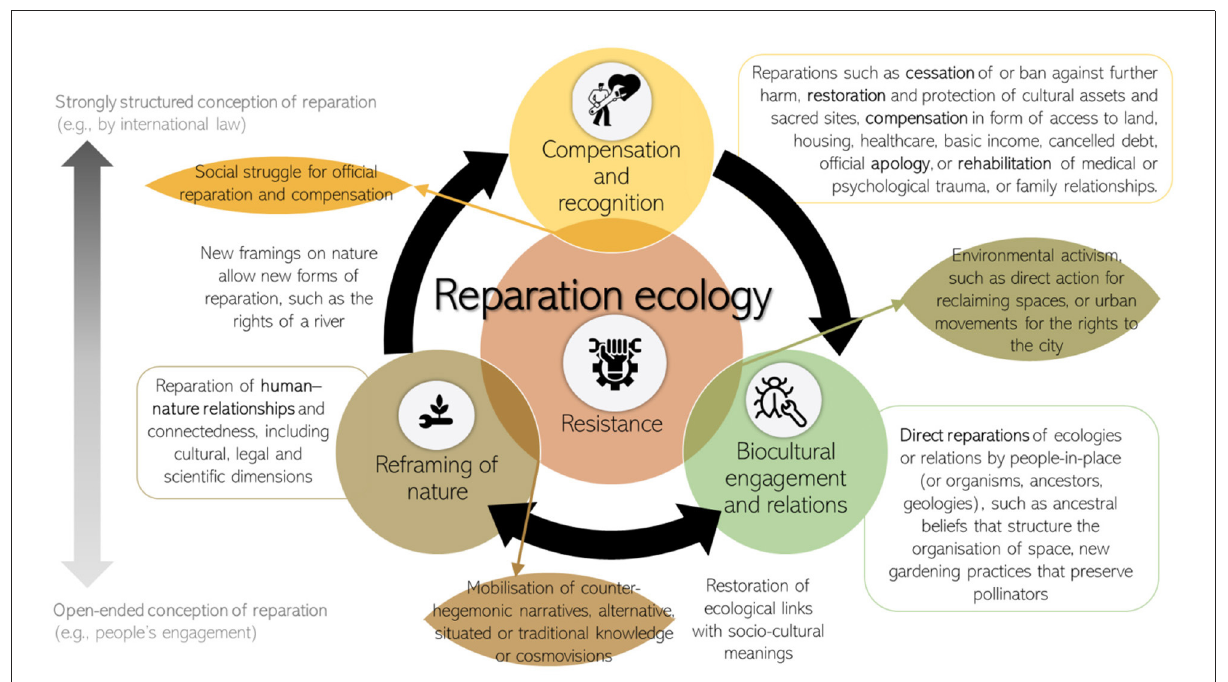
FIGURE1 Map and key dimensions of reparation ecology. Source: elaboration of the authors based on key references. Incipient work on reparation ecology has favored different dimensions illustrated here: Blanco-Wells (2021) principally maps onto the bottom-left (reframing nature) and Papadopoulos et al. (2022) onto the bottom-right (biocultural engagement), while some of the more politically charged literature maps onto the top (compensation and recognition, e.g., Sharife and Bond, 2013 on litigation for human and ecological loss and damage, and Ritchie and Stahly-Butts, 2019, on reparation for Black lives), top-left (e.g., Patel and Moore, 2017 on reparation ecology within the web of life), and top-right (e.g., Cadieux et al., 2019 on abolitionist agro-movements). All studies contain elements of